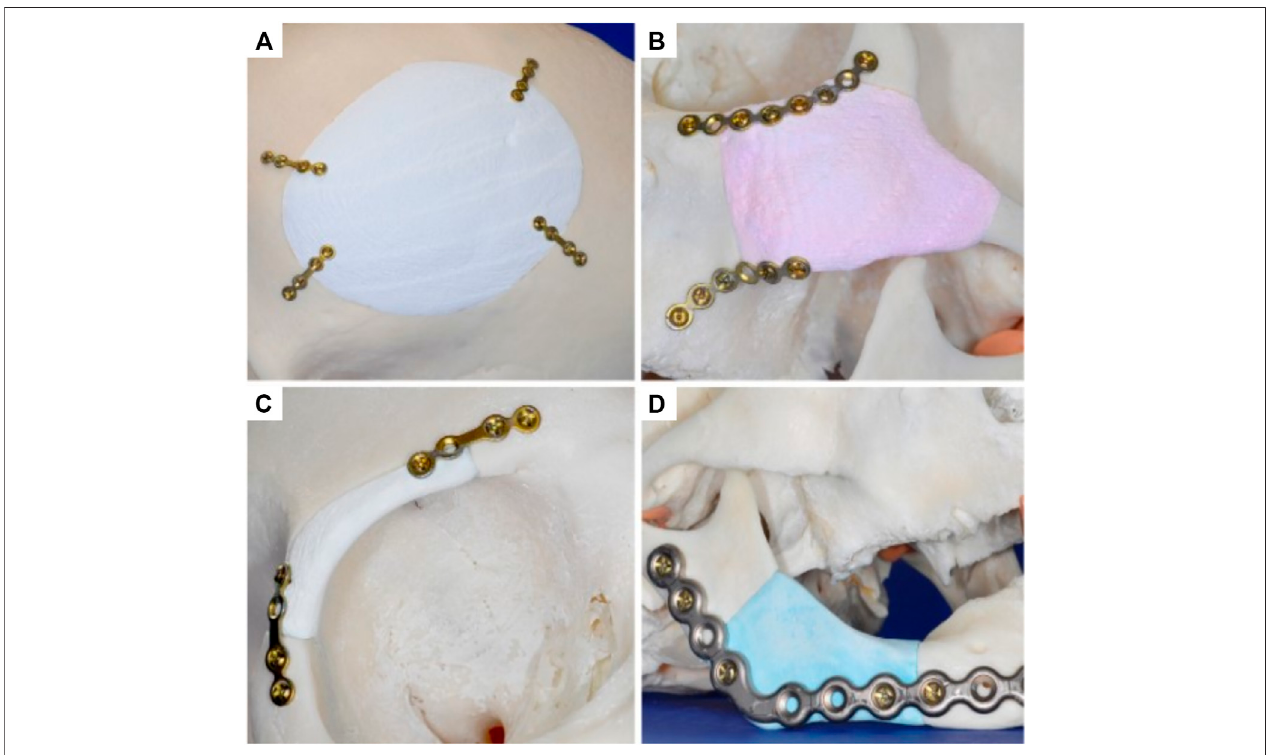
FIGURE 1 | Manufacturing of anatomically accurate 3D-printed bioceramic scaffolds for bone regeneration demonstrating the versatility of the fabrication method for various applications in the craniofacial area. Reproduced with permission from (Klammert et al., 2010) (A – D) .